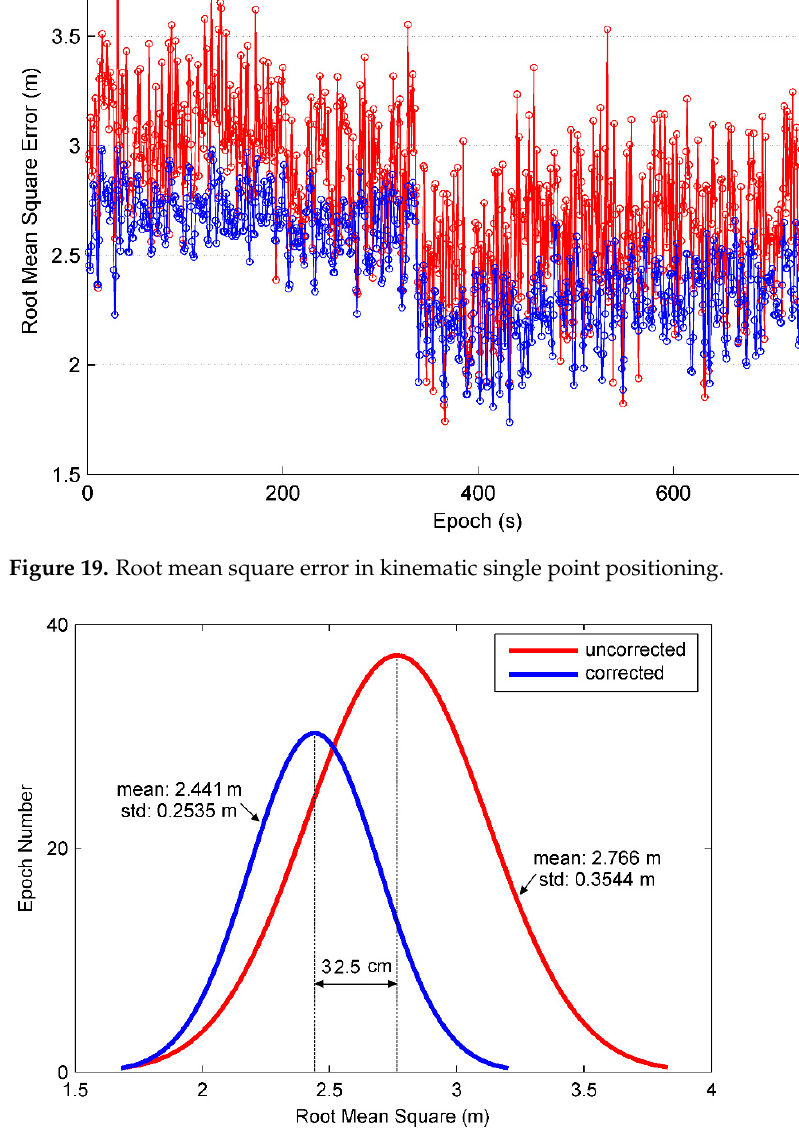
Figure 21. Base station for DGNSS experiment on SYSU campus. CCR (corrected code range) for BDS C14 is plotted as one example in Figure 22a and it is decomposed into nine IMF layers by EMD. Relative code multipath for C02, C06, C14, and G10 are given by Figure 22b. The RMSE of the positioning is plotted in Figure 22c, it can be seen that the RMSE is decreased after the multipath is corrected by the proposed method. Figure 22d shows a Gaussian distribution of the RMSE, it can be seen that the mean and the standard deviations decrease from 1.565 m to 1.254 m and 0.61 m to 0.475 m, respectively after the multipath correction is applied. These suggested that rela- tive code multipath can be identified based on the mechanism discussed previously and be removed from CCR to achieve an improved differential positioning result.